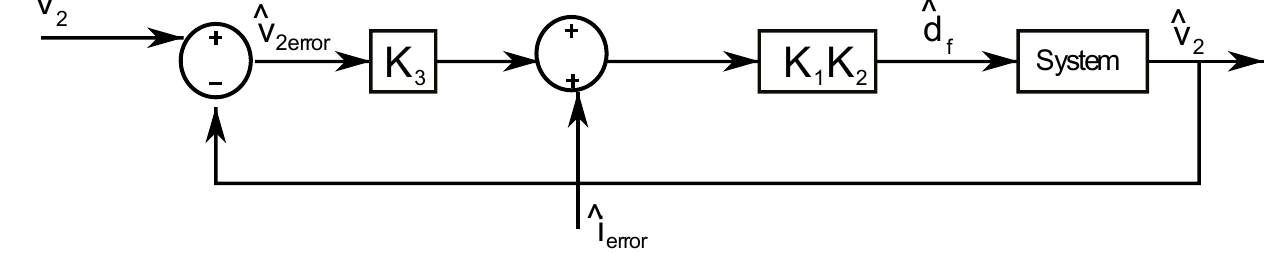
Figure 6. MPC control scheme.